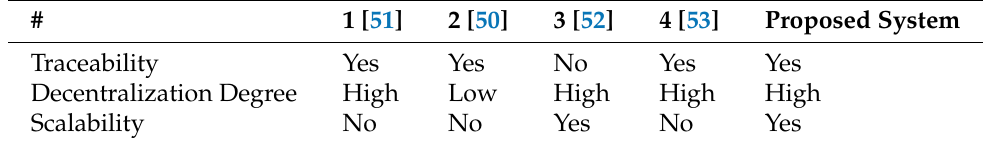
Figure 9. Relationship between the chain data and response time. Table 7. Various Schemes